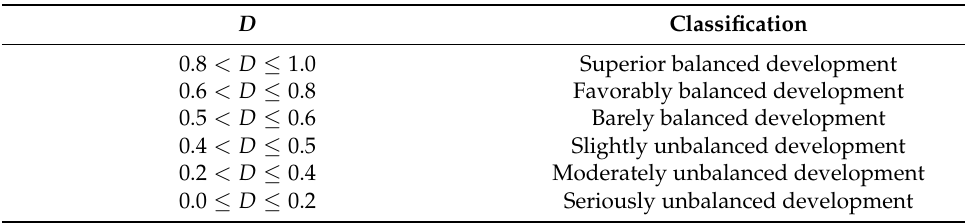
Table 2. Classification of coupling coordination degree.